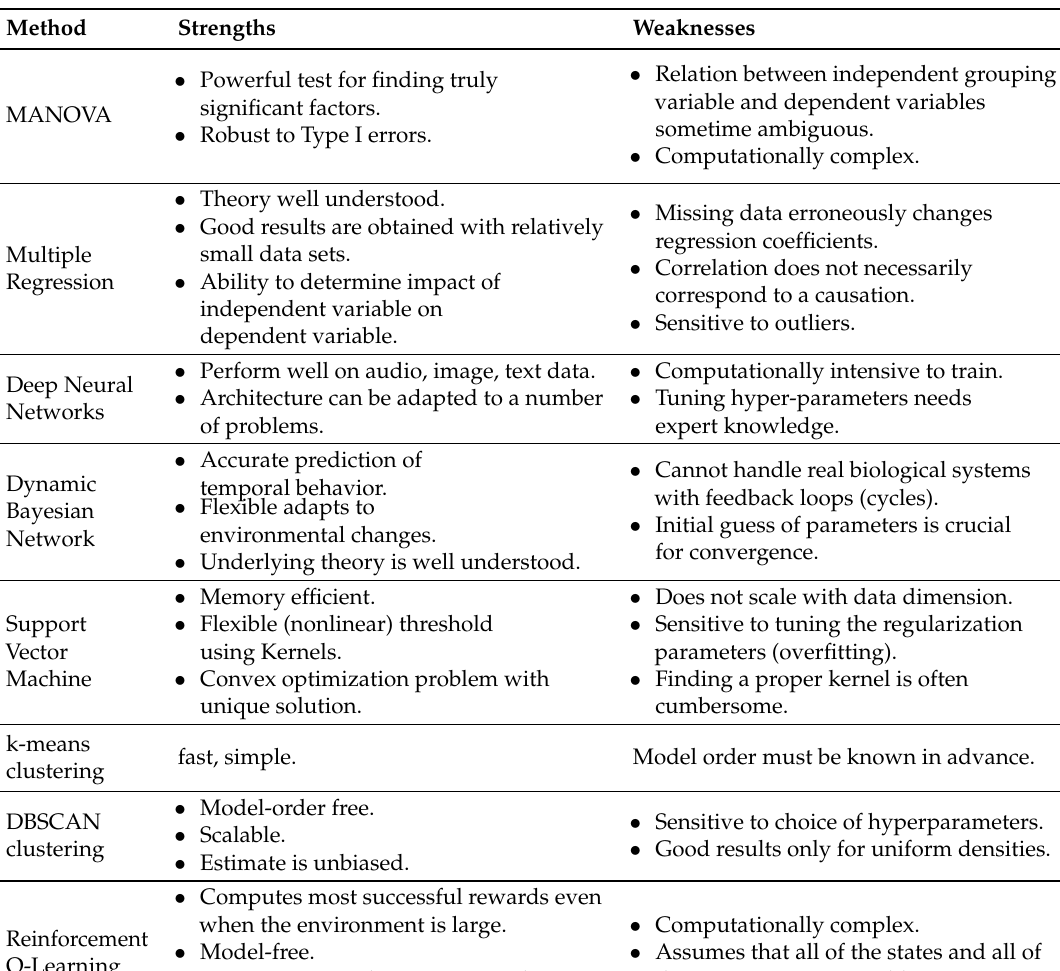
Table 1. Comparison of common statistical models and machine learning